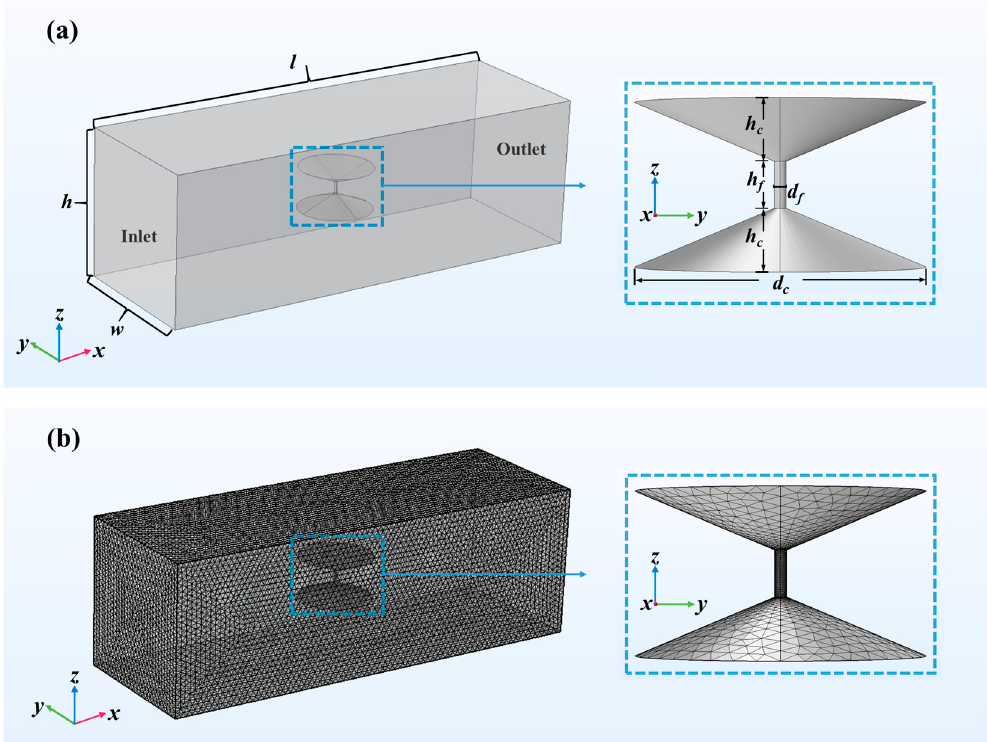
Figure 2. LIFPA simulation model in COMSOL. The coordinate origin is located at the geometric center. ( a ) Geometry of computation model of LIFPA. The inset shows the structural details of the laser focus region, which is also the reaction region; ( b ) details of mesh in COMSOL simulation.